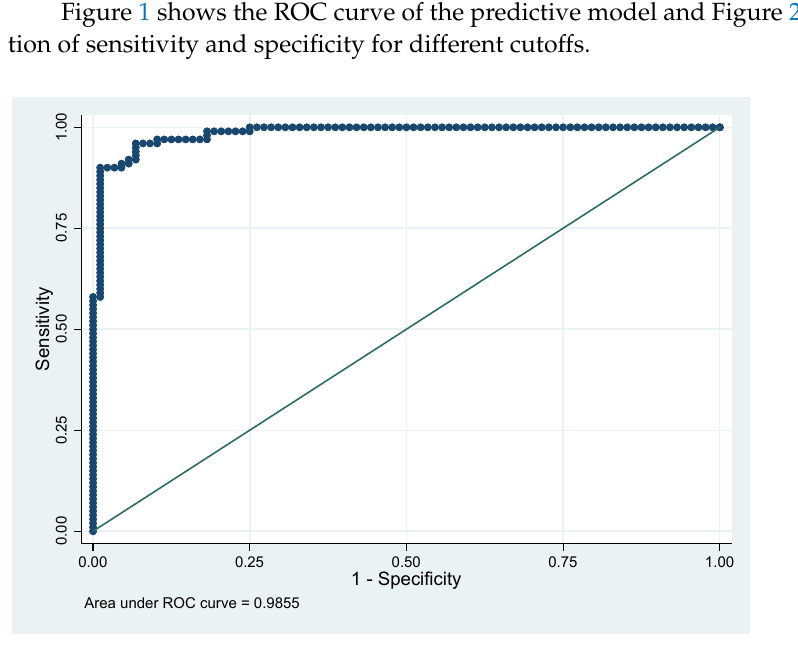
Figure 1. The performance of the model with an area under the ROC curve of 98.55%.